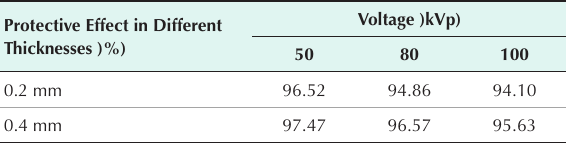
Table 3 . The Protective Effect of Shielding at Different Thicknesses and Voltages )8) Protective Effect in Different Thicknesses